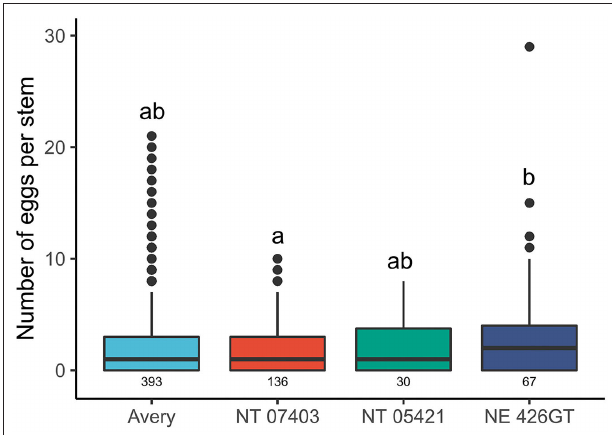
FIGURE 2 | Effects of triticale genotypes and wheat on the number of wheat stem sawfly eggs found stems. Sample size is represented by the numbers beneath each boxplot (total stems cut). The boxes represent the 25th and 75th percentiles; the horizontal line in each box indicates the median. The whiskers signify maximum and minimum values and circles indicate outliers. Letters indicate significant pairwise differences ( P < 0.05, Tukey HSD corrected post hoc test). Pairwise comparisons and estimated marginal means, provided in Supplementary Figure 1